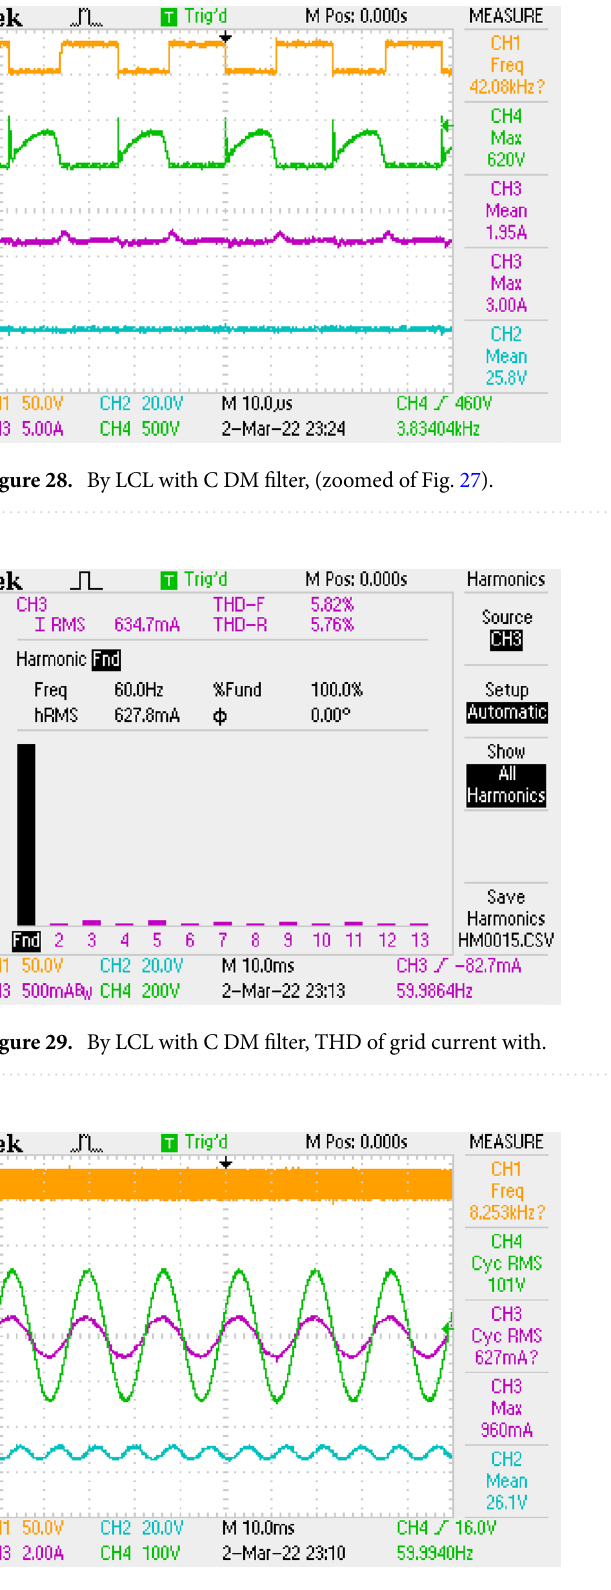
Figure 30. PWM, voltage-current of grid, voltage of output, by LCL with C DM